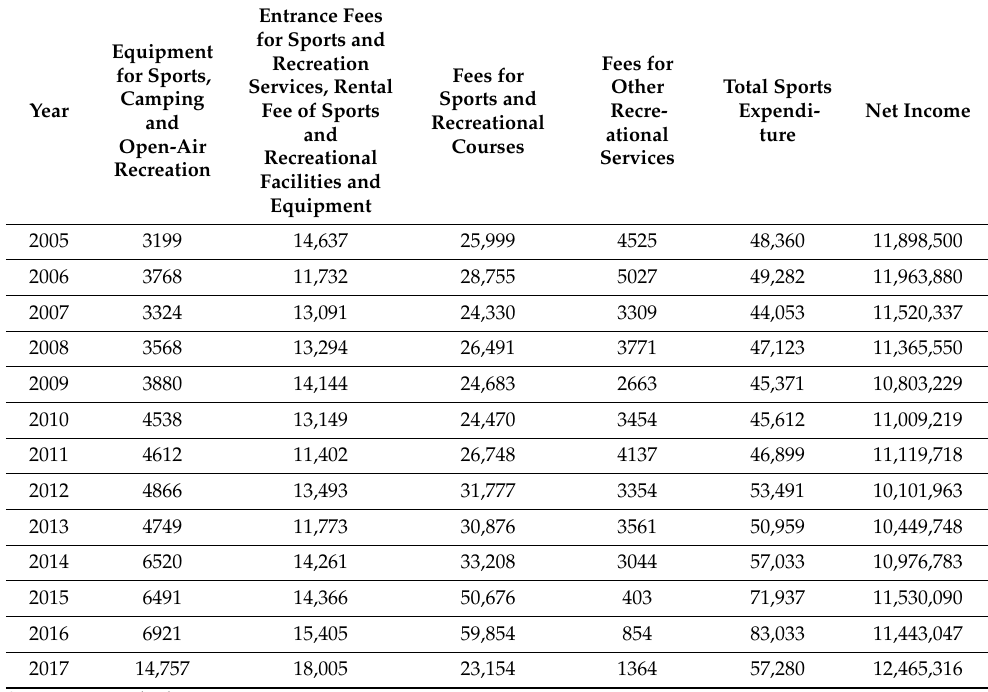
Table A2. Aggregate values of sports expenditure and income between 2005 and 2017 (million